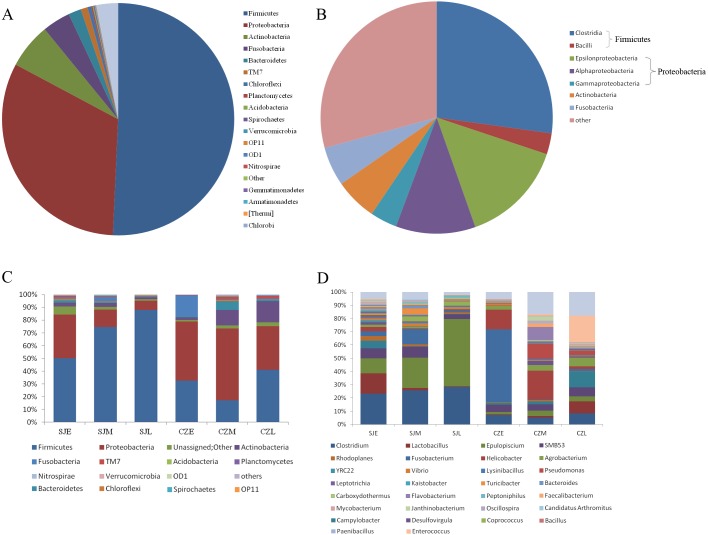
Relative abundance of gut bacteria at the phylum, class and genus levels at two lakes.(A) Relative abundance of the dominant phyla in all samples. (B) Relative abundance of the dominant classes in all samples; Rings represent corresponding phylum (Firmicutes in blue and Proteobacteria in red) for each of the most frequently represented class. (C) Relative abundance at the phylum and (D) relative abundance at the genera at different periods in the two lakes.